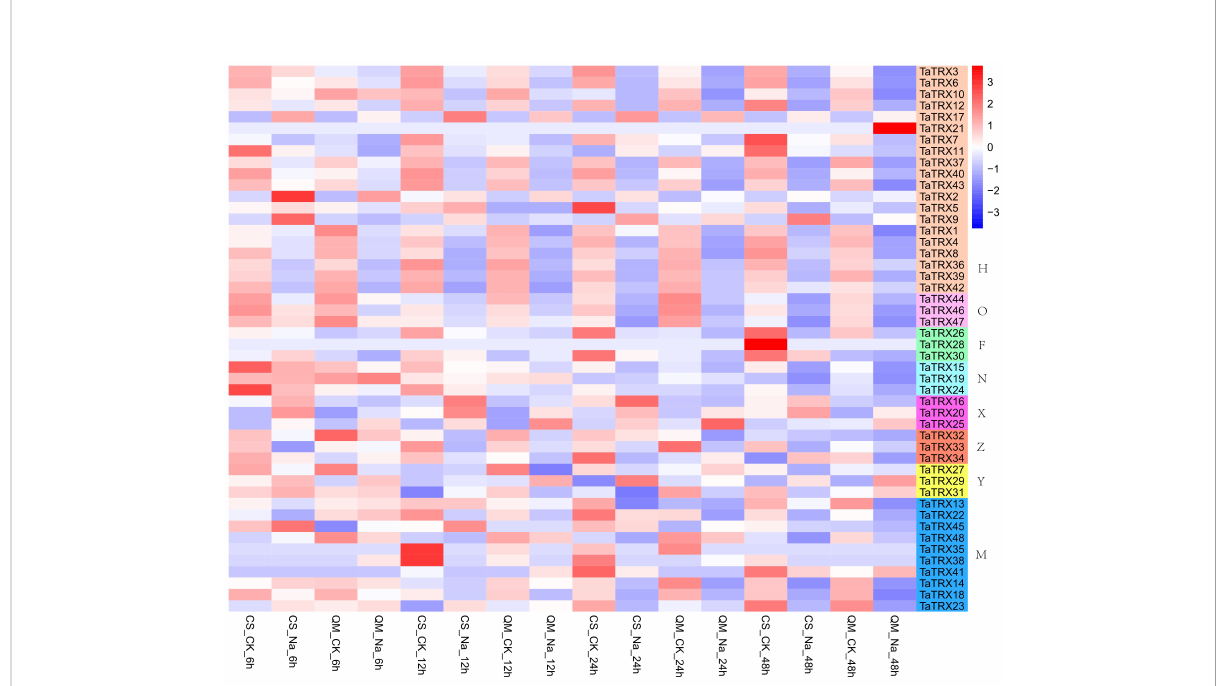
FIGURE 8 Expression pro fi les of typical TaTRX genes in wheat treated with NaCl for 6h, 12h, 24h and 48h. CS and QM represent wheat varieties “ Chinese Spring ” and “ Qing Mai 6 ” respectively; CK represents no stress treatment of wheat; Na represents NaCl treatment of wheat. The red, white and blue cells represent the highest, medium and lowest gene expression levels, respectively. H, O, F, N, X, Z, Y, and M represent different subtypes of typical TaTRX genes, respectively. The colour scale represents Log2 expression